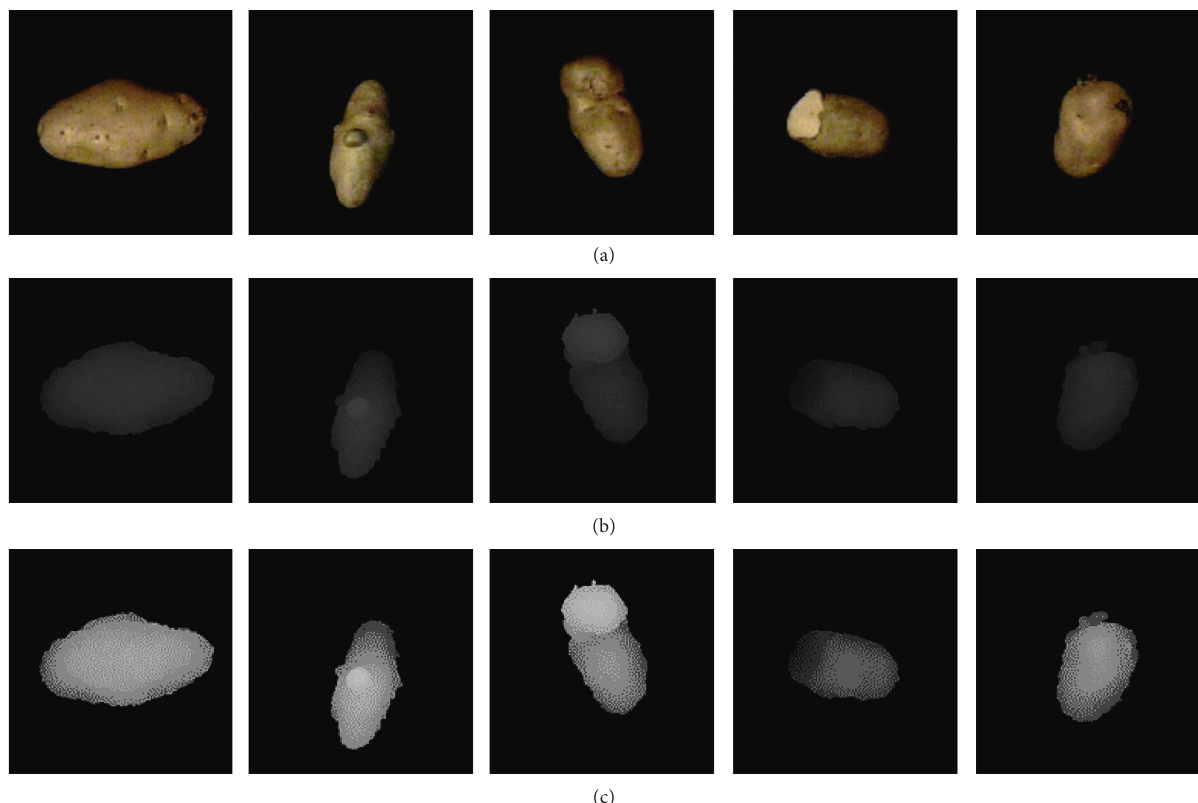
Figure 2: Image comparison for potato features. (a) Color images of normal, bump, hollow, machinery injury, and sprout potatoes. (b) Depth images of normal, bump, hollow, machinery injury, and sprout potatoes. (c) Enhanced depth images of normal, bump, hollow, machinery injury, and sprout